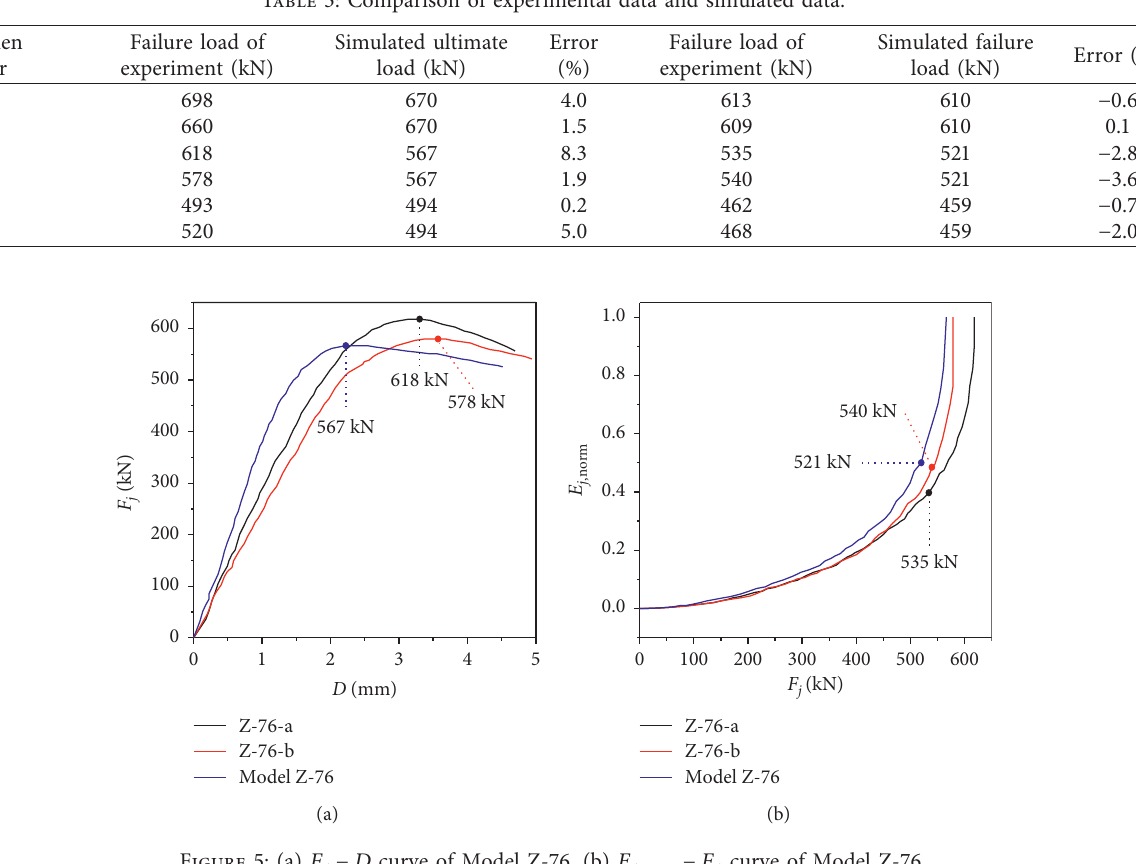
− F j, norm j curve of Model Z-76.